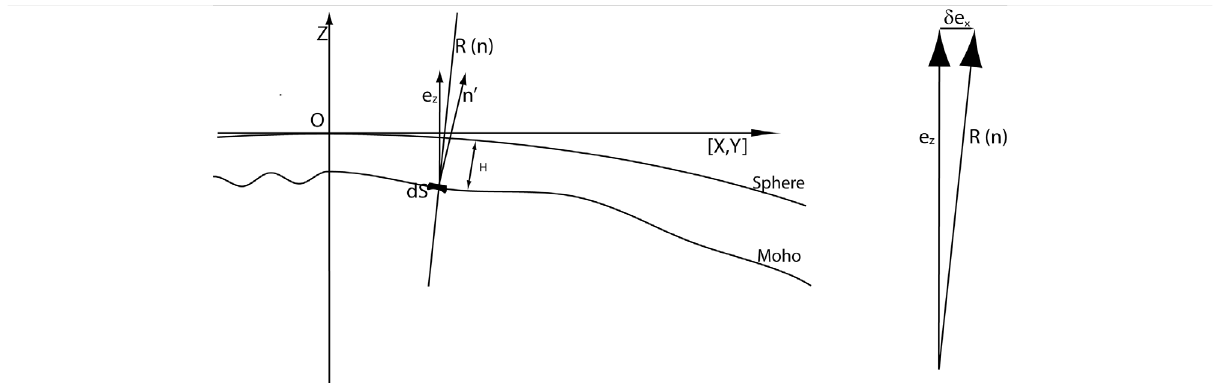
Figure 1. Spherical geometry and planar